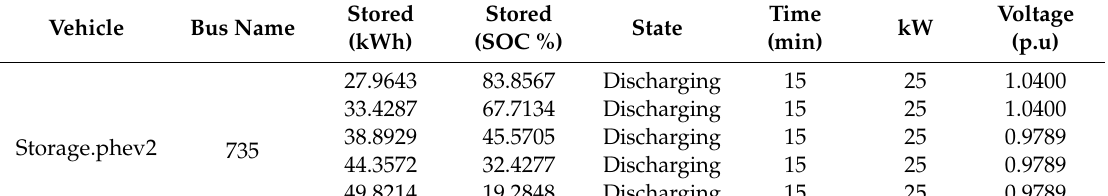
Table 8. Vehicles discharging data through ehicle-to-grid (V2G) technology.